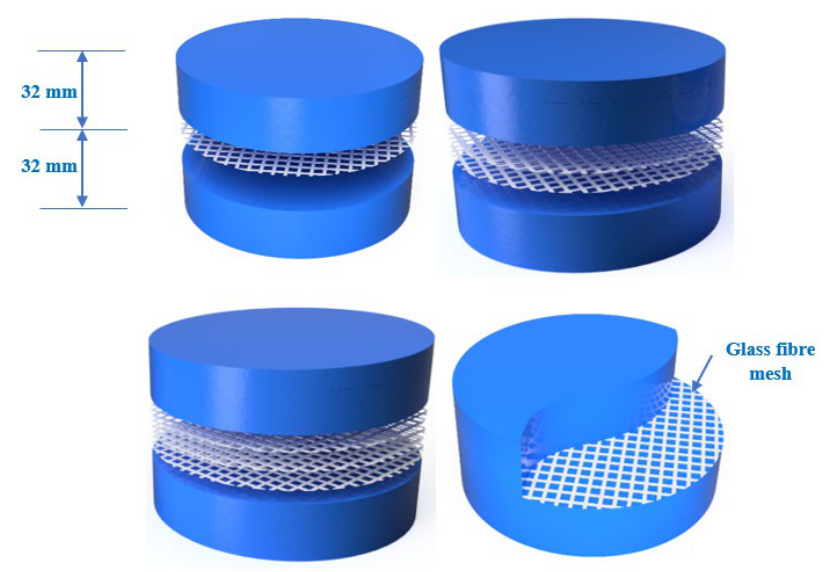
Table 1. Mixing composition of TECAFC.